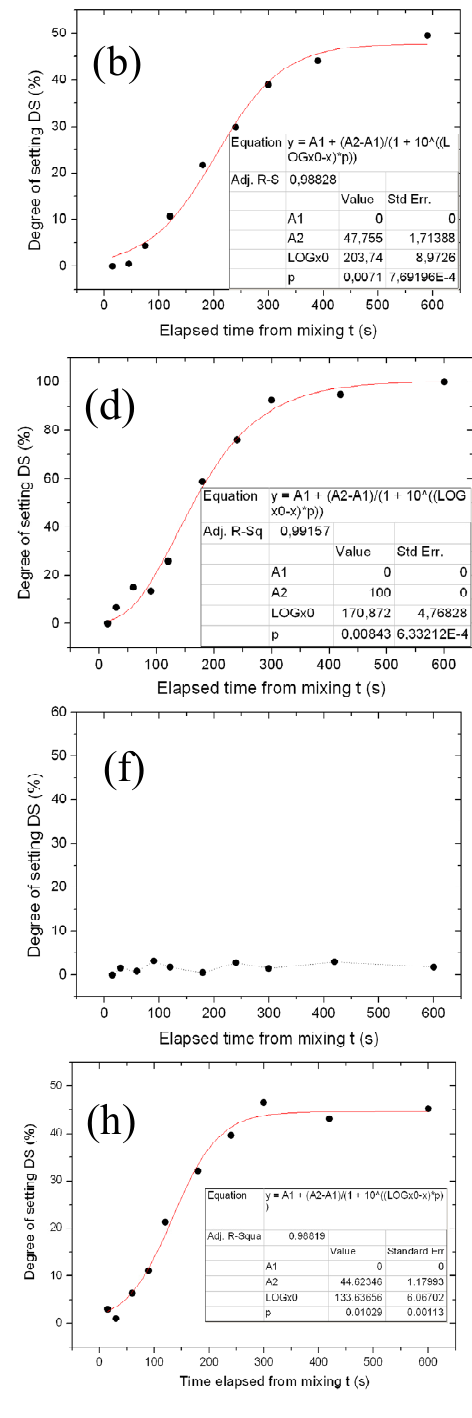
Figure 4. ( a ), ( c ), ( e ) and ( g ): regions with the peaks selected as representative of the expected setting process of Impri, Aqua, Flexi, and Impre over the time. ( b ), ( d ), ( f ) and ( h ): DS calculated from the respective peak signal, versus time, and—where possible—sigmoidal fit to the